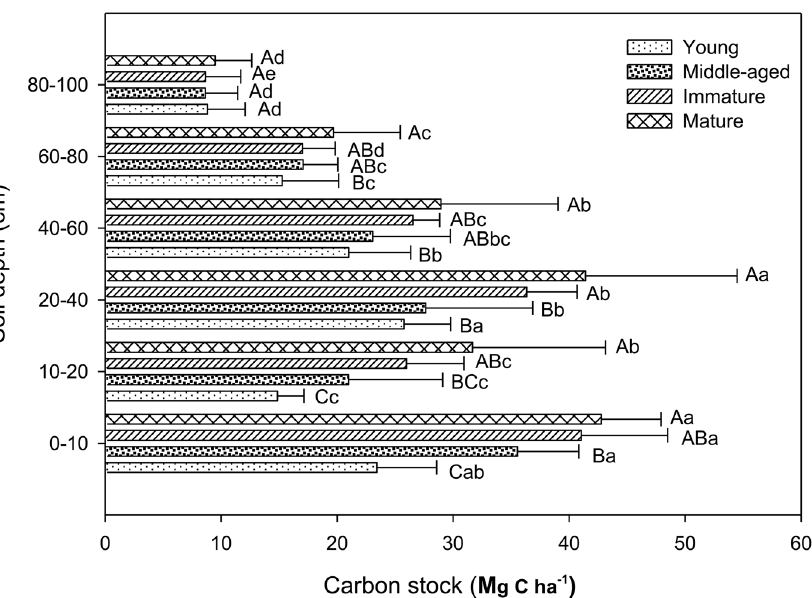
Figure 4. MSOC stocks at different soil depths in the P.tabulaeformis forests. Different uppercase letters indicate a significant difference between age groups at the same horizon ( p , 0.05), different lowercase letters indicate a significant difference between different soil depths within- stand ( p , 0.05). Error bars standard deviation ( SD ).